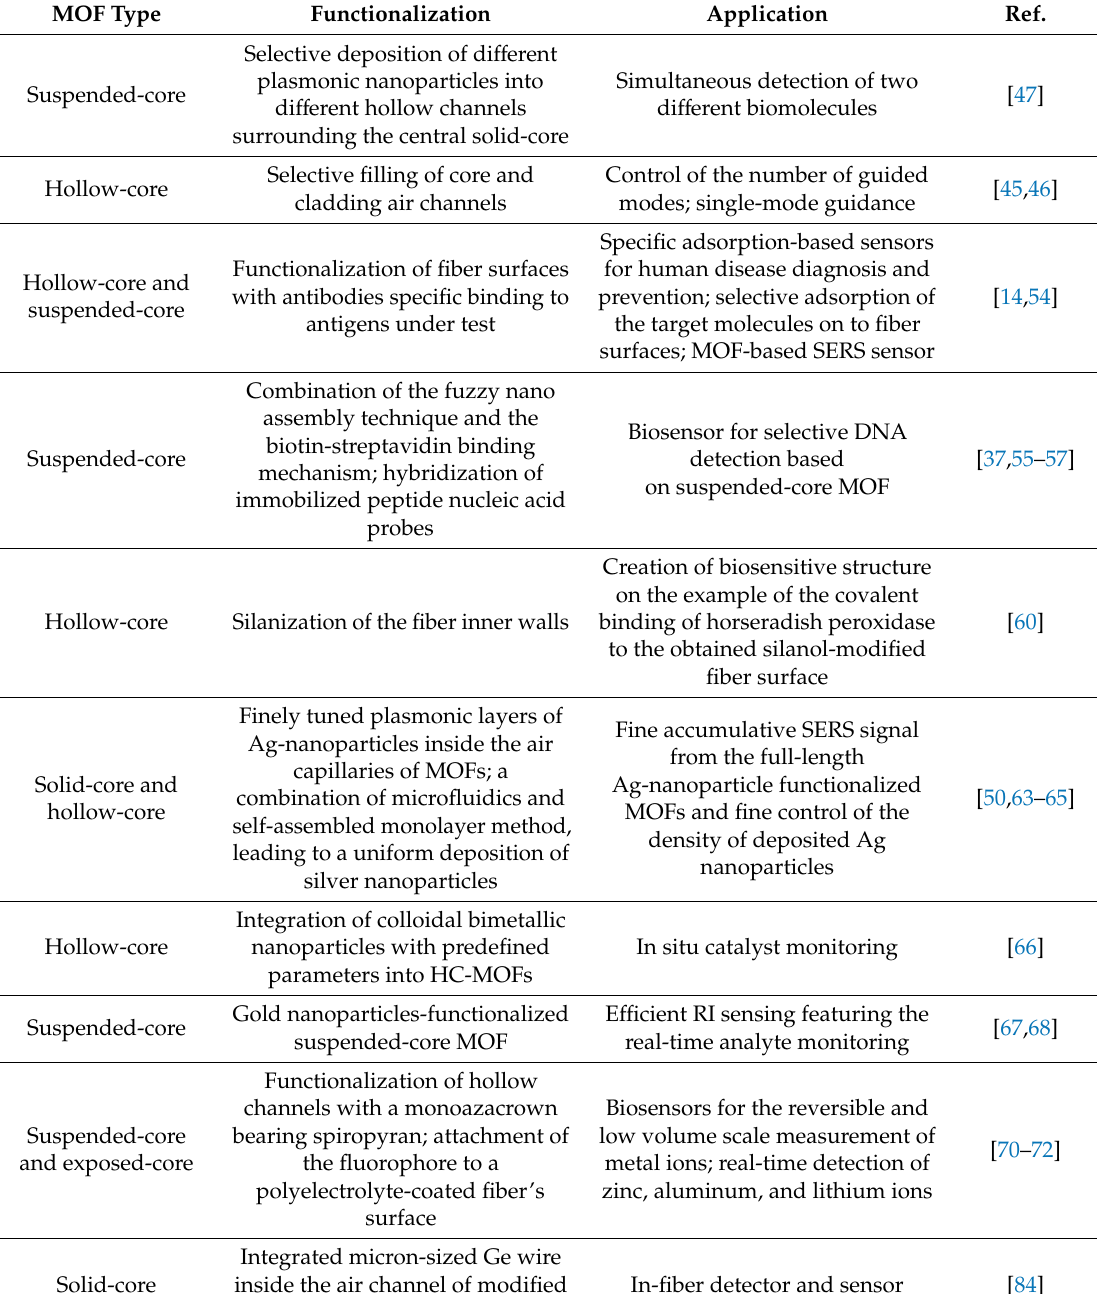
Table 1. Summary of the reviewed MOF functionalization technique and their potential applications. MOF